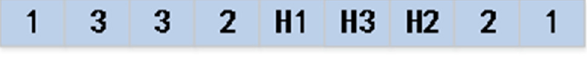
Figure 3. Process Encoding with the Heat Treatment as a Node.